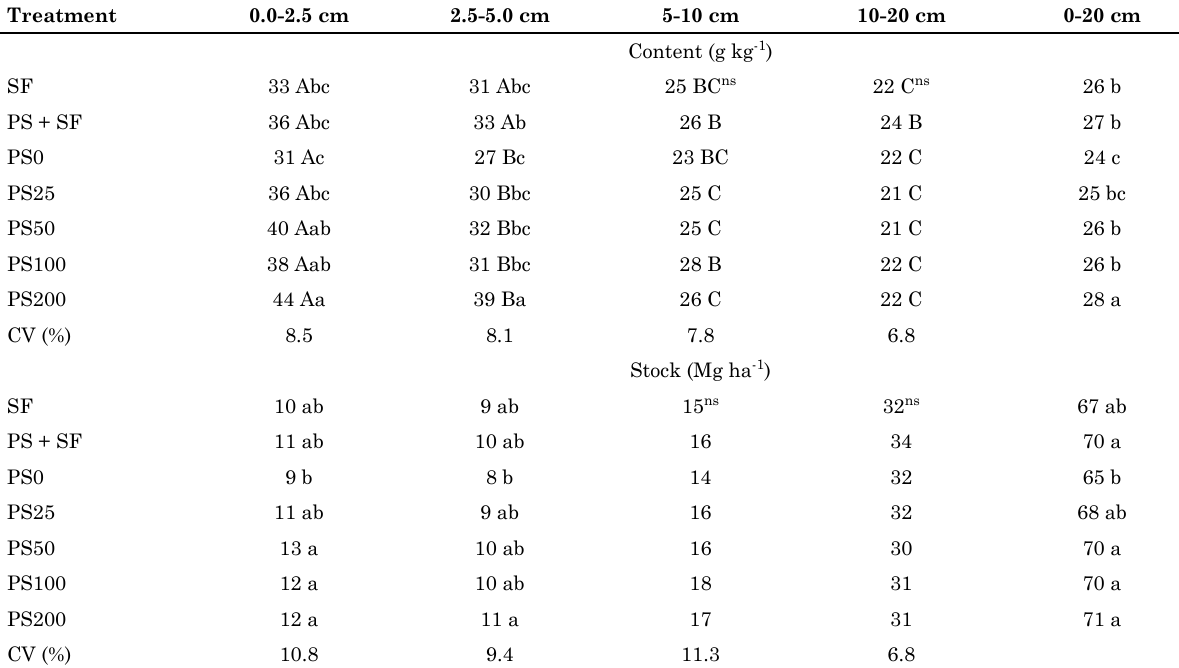
Table 4. Contents and stocks of mineral-associated organic carbon (MAC) with particle diameter of <53 μm in the layers 0.0-2.5, 2.5-5.0, 5-10, 10-20 and 0-20 cm of a typic Hapludox cultivated for nine years with no-tillage maize and oat and annually fertilized with soluble fertilizer (sF), pig slurry (Ps) at rates up to 200 m 3 ha -1 and combined Ps + sF. Mean of four replications